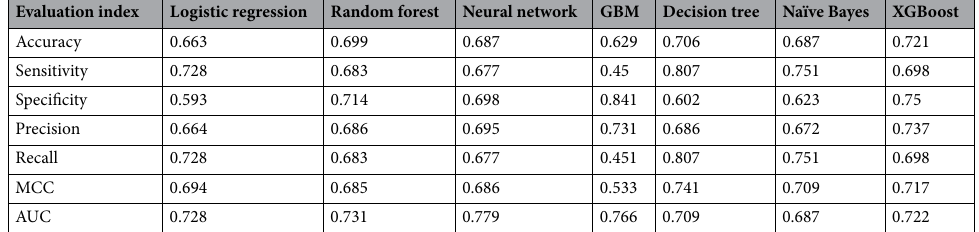
Table 3. The performance of different Machine Learning Algorithms in Parkinson’s disease prediction (Model3). GBM Gradient Boosting Machines, XGBoost eXtreme Gradient Boosting, MCC Matthews correlation coefficient, AUC area under the receiver operating characteristic